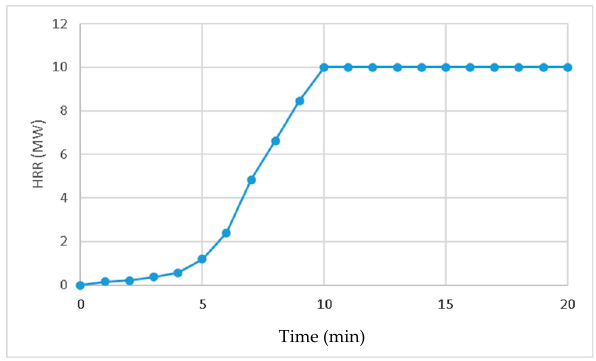
Figure 4. HRR vs. Figure 4. HRR vs. time. Figure 4. HRR vs. time.